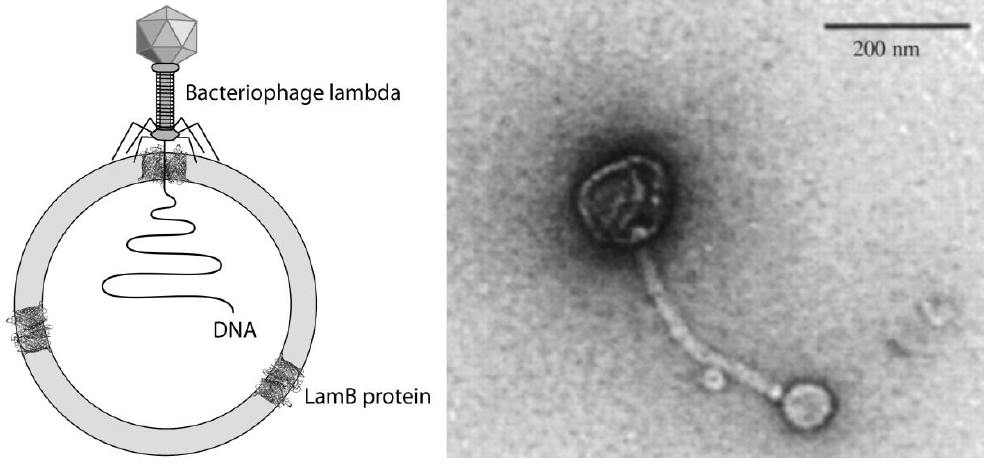
Figure 14. Introduction of surface-exposed binding sites into block copolymer vesicles by reconstituting membrane proteins in the vesicle membrane. The channel protein LamB in PMOXA- b -PDMS- b -PMOXA vesicles was recognized by a λ phage and triggered the injection of DNA from the phage into the vesicle. ( a ) Schematic representation, ( b ) TEM micrograph showing a phage bound to a vesicle. Reproduced and adapted by permission of the National Academy of Sciences of the United States of America